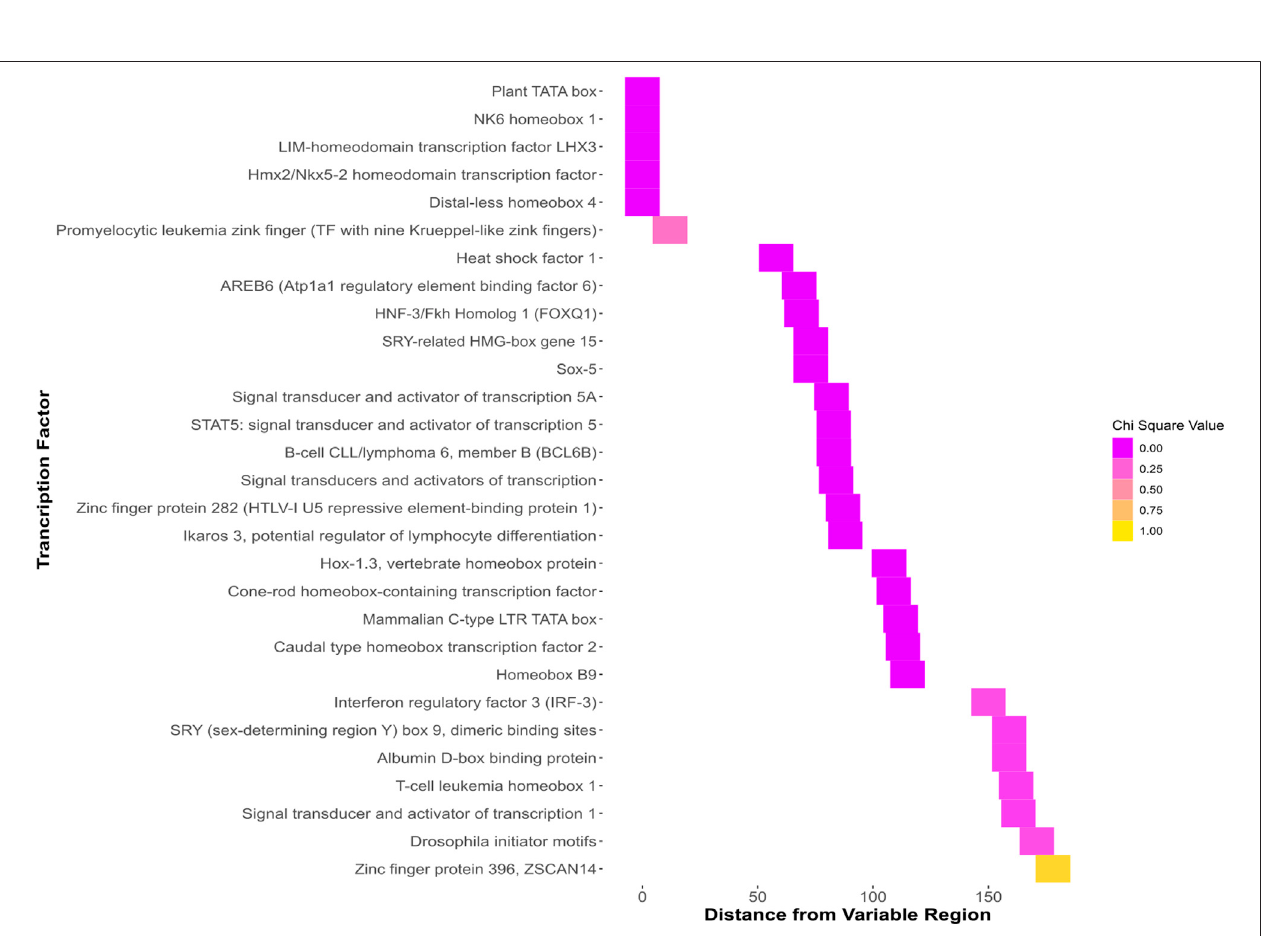
FIGURE4| HeatmapshowingallbindingsitespredictedtobindtheGGsequence.The y axisshowsthenameofeachpredictedbindingsite.The x axisshowsthe distanceofeach predicted site from the region beginning with theindel and ending withthe SNP.The colors, ranging from dark pinkto yellow represent thechi-squared value when the predicted binding sites of the GG and TT genotypes are analyzed with a chi-squared test.